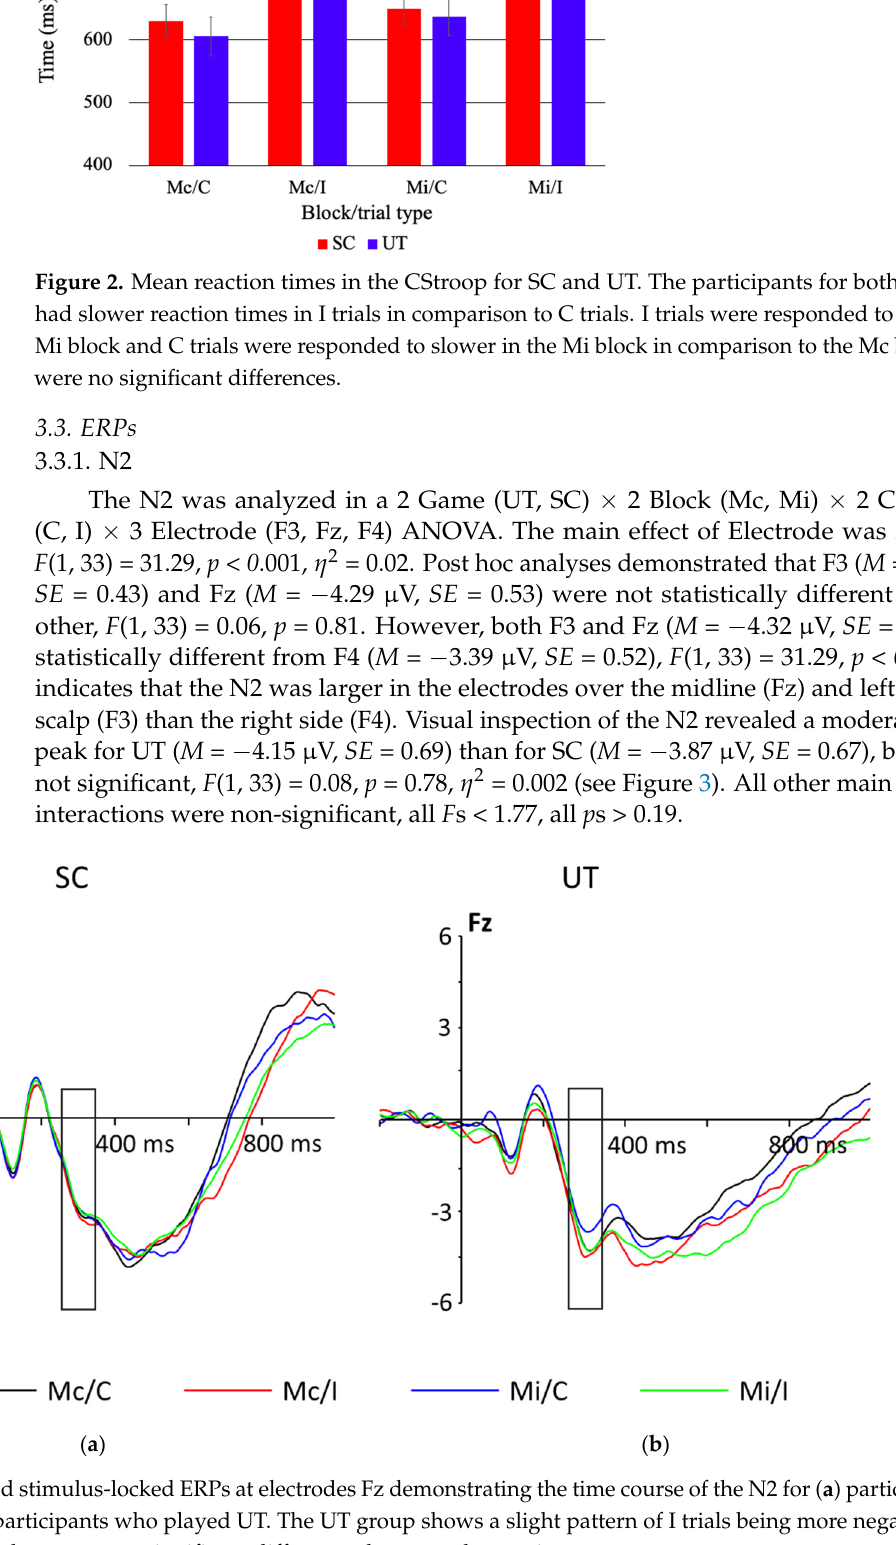
Figure 1. Mean accuracy in the CStroop for SC and UT. The participants in both gaming groups were less accurate for I trials in comparison to C trials. I trials were more accurate in the Mi block than the Mc block. There were no significant differences.